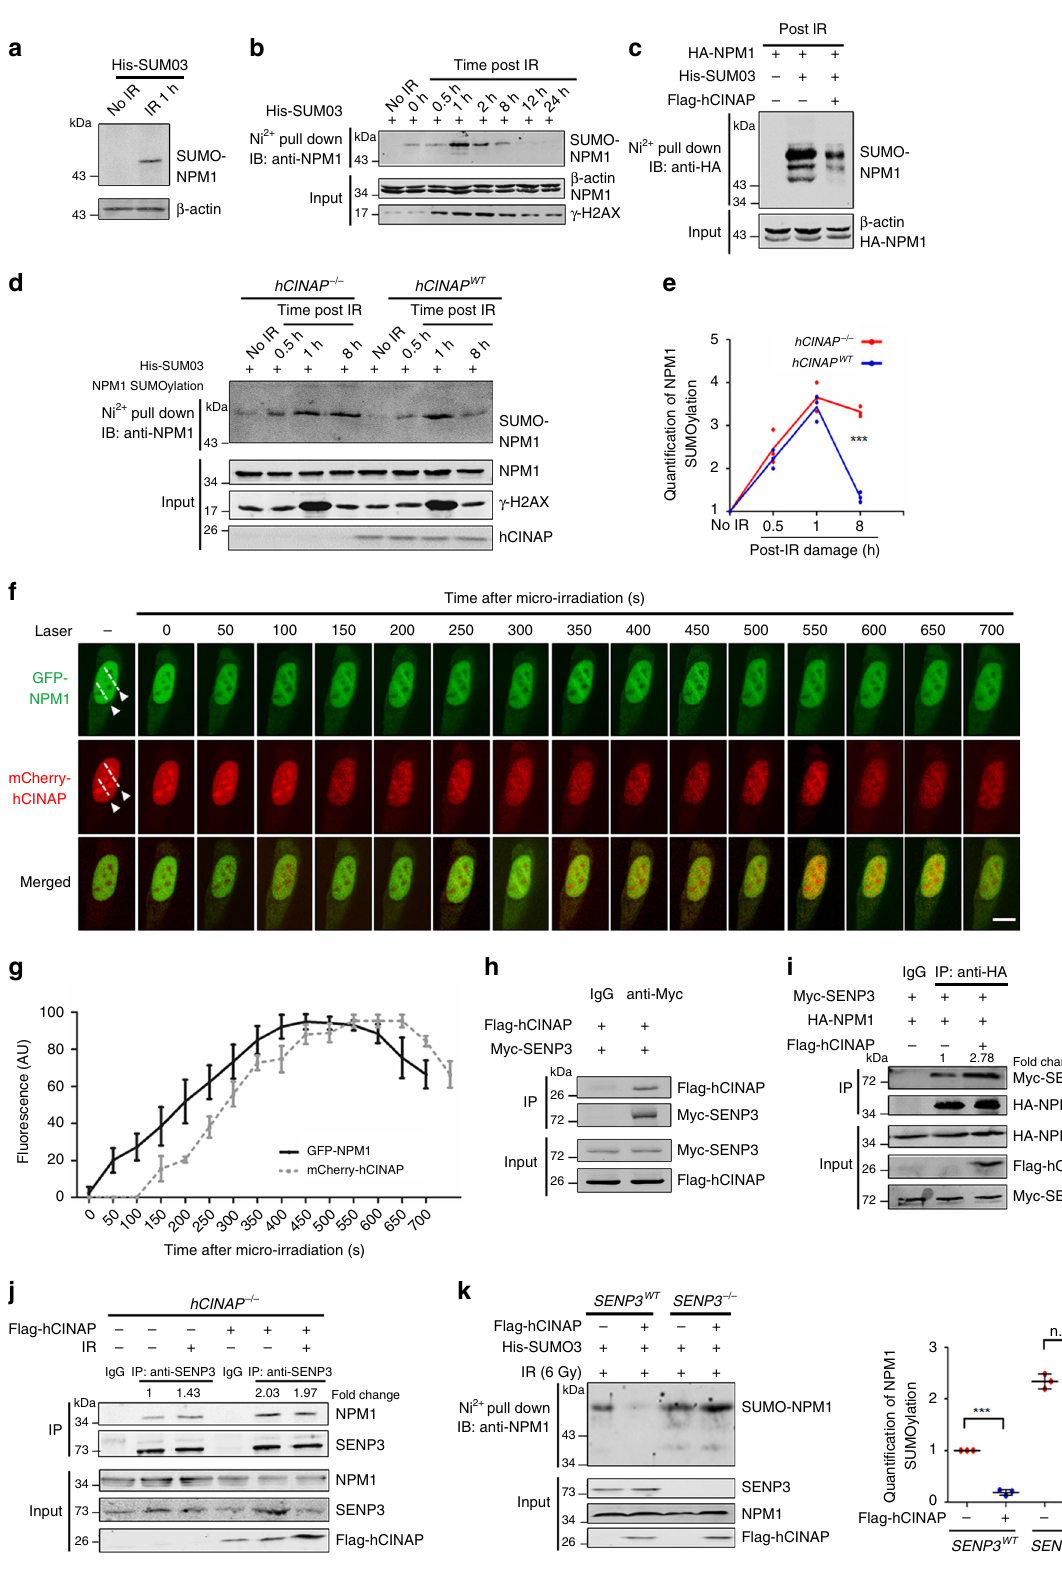
percentage of GFP-positive cells (Fig. 5a), demonstrating that loss of hCINAP function impairs the pro fi ciency of error-free HR repair. We assessed the abundance of BRCA1 foci in hCINAP WT and hCINAP − / − U2OS cells at different time points following IR